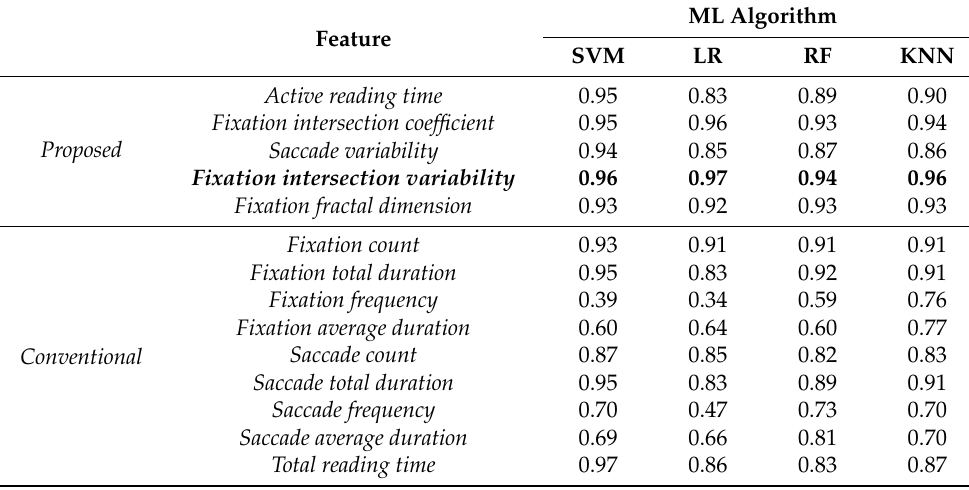
Table A2. Specificity for single feature inputs.